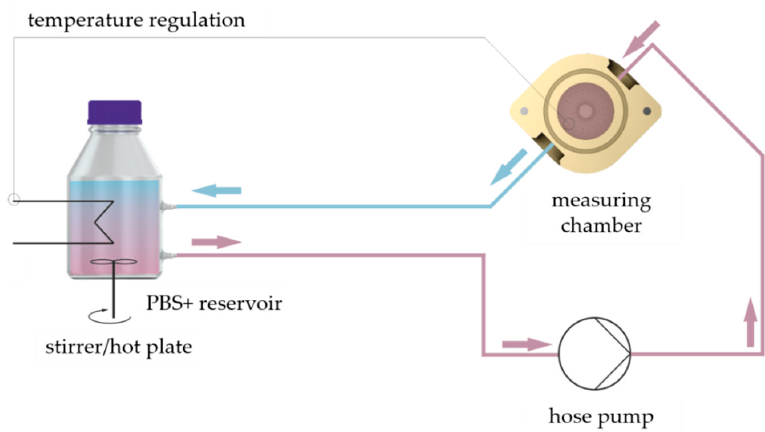
Figure 4. Experimental set-up for compression tests of hydrogels in a swollen state at 37 °C. The measuring chamber was flushed with 37 °C warm PBS+ throughout the measurements. The PBS+ was warmed on a magnetic stirrer/hotplate and pumped in a closed circuit through the measuring chamber by the hose pump.